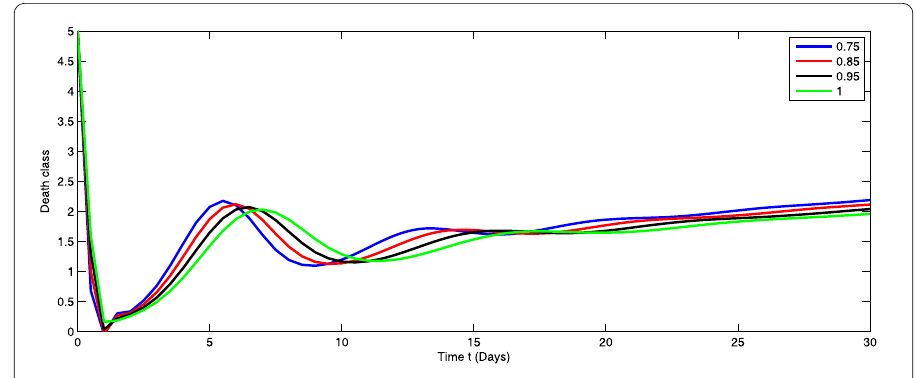
Figure 5 Graphical representation of the approximate solution D for the first ten terms at different fractional order